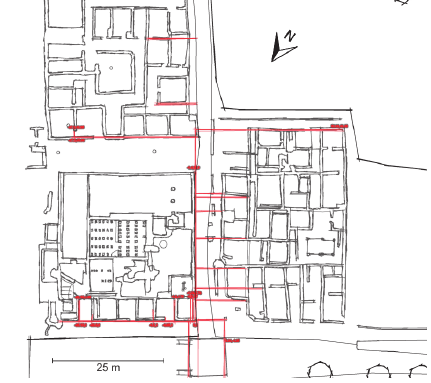
Figure 4. Distribution of image